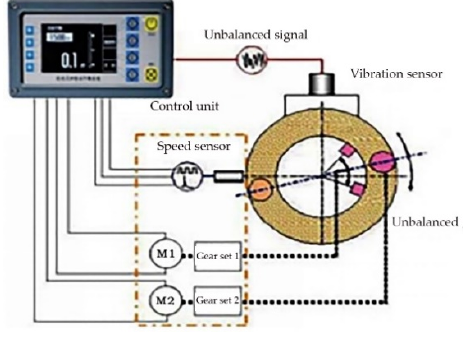
Figure 5. Balance principle.